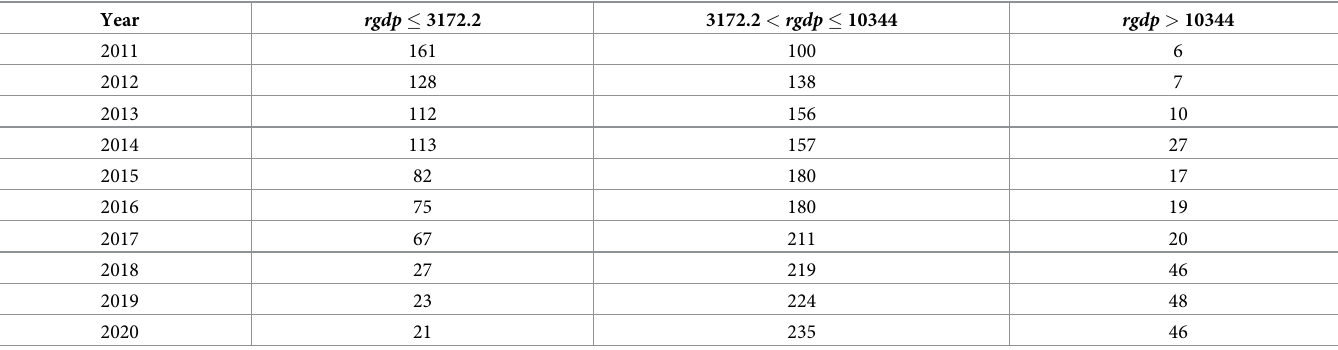
Table 7. 2011–2018 number of prefecture-level cities by